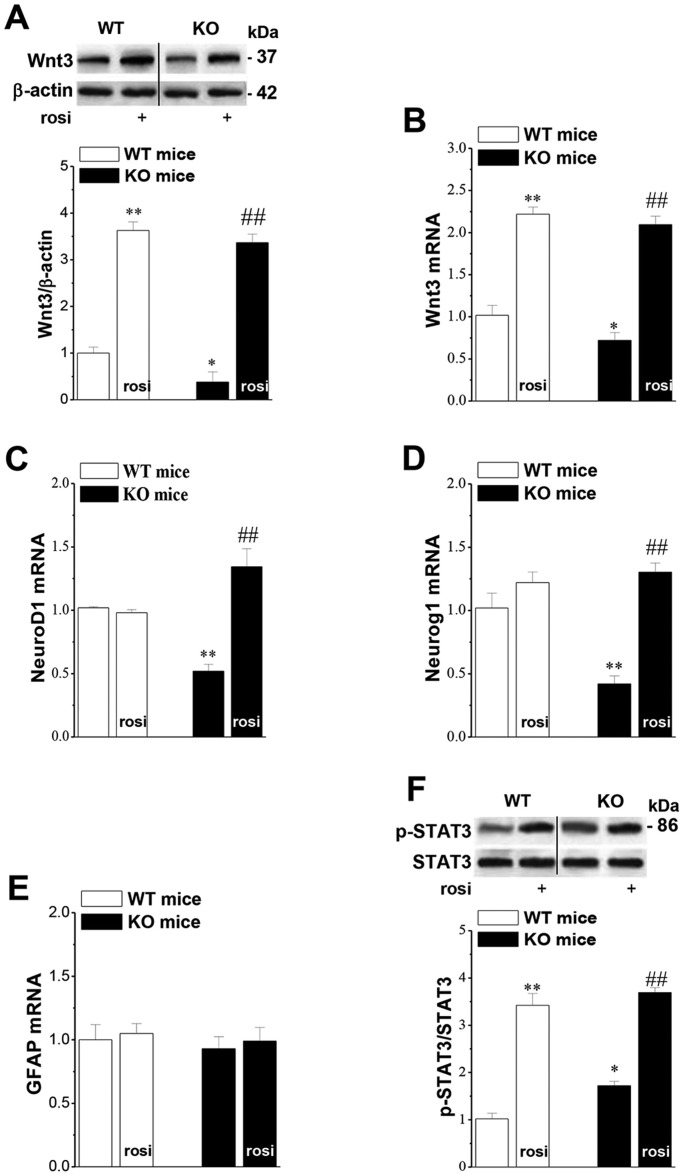
Influence of seipin deficiency on the Wnt3 signaling pathway. (A) Densitometric values of Wnt3. *P<0.05, **P<0.01 vs WT mice; ##P<0.01 vs seipin-nKO mice. (B) Bar graph shows mean level of Wnt3 mRNA. *P<0.05, **P<0.01 vs WT mice; ##P<0.01 vs seipin-nKO mice. (C-E) Bar graphs show the levels of NeuroD1 mRNA, Neurog1 mRNA and GFAP mRNA normalized by control values in WT mice and seipin-nKO mice. (C) **P<0.01 vs WT mice; ##P<0.01 vs seipin-nKO mice; (D) **P<0.01 vs WT mice; ##P<0.01 vs seipin-nKO mice. (F) Densitometric values of phospho-STAT3 (Tyr705). *P<0.05 vs WT mice, **P<0.01 vs WT mice; ##P<0.01 vs seipin-nKO mice.